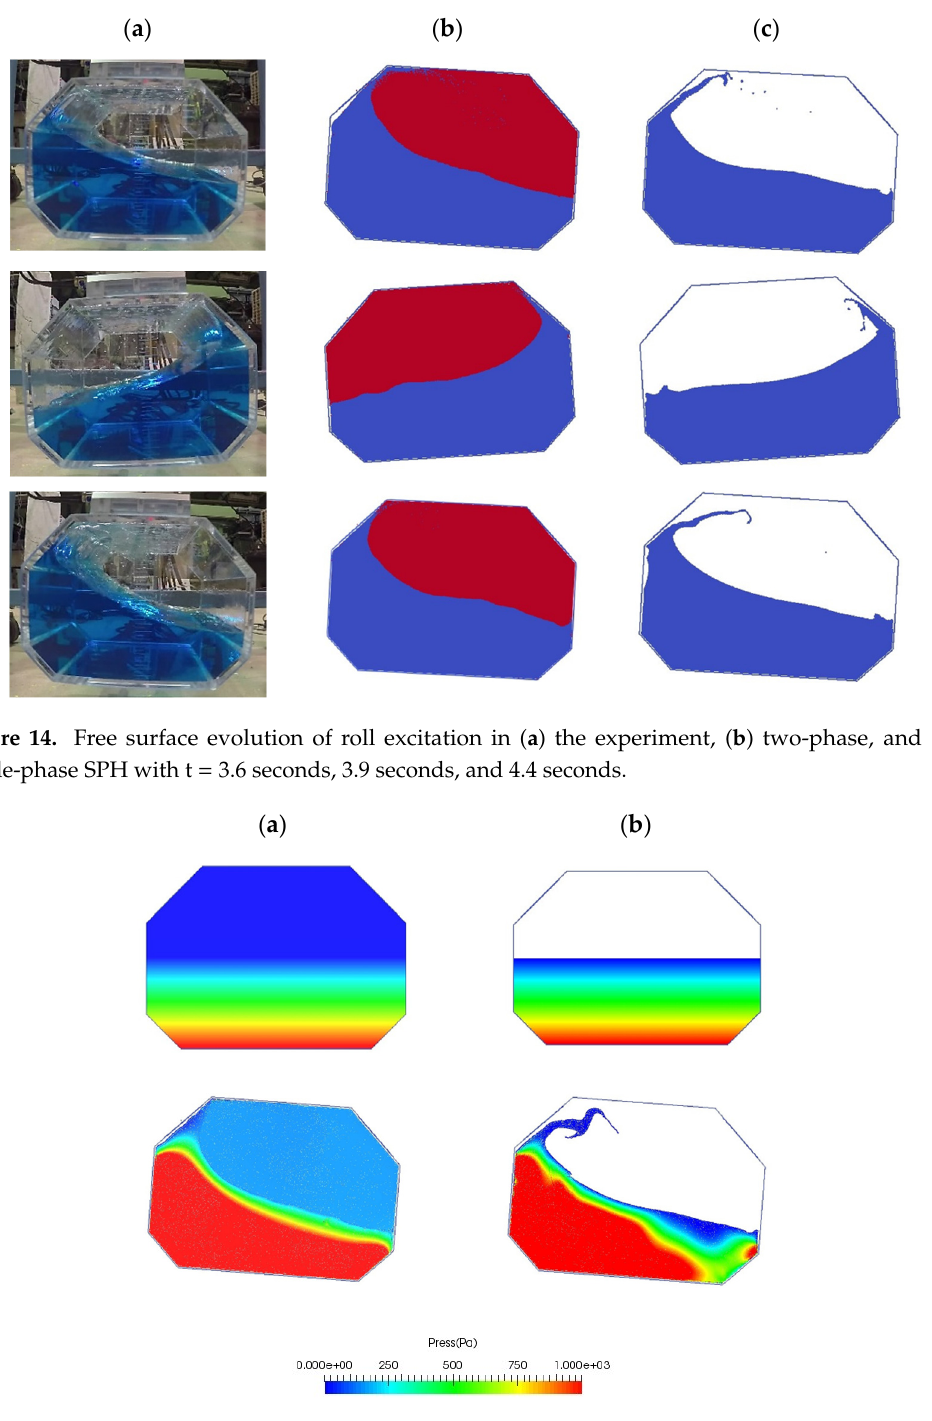
Figure 15. Pressure contours with a filling ratio of 50% for ( a ) two-phase and ( b ) single-phase SPH with t = 0.0 seconds and 12.15 seconds.